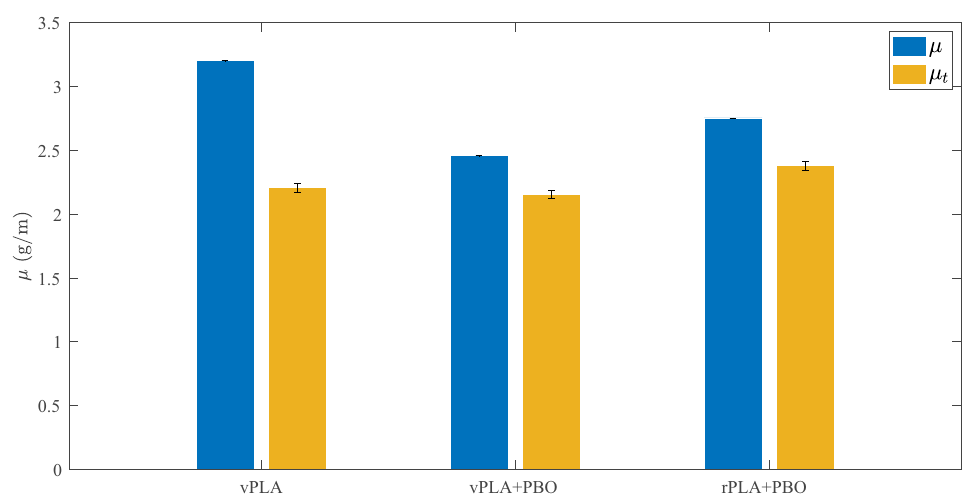
Figure 3. Linear mass density of the filament produced with virgin PLA (vPLA), virgin PLA mixed in the presence of PBO (vPLA+PBO), and recycled PLA mixed in the presence of PBO (rPLA+PBO). Table 2. Characteristics of the filament produced with the virgin PLA (vPLA), recycled PLA (rPLA), virgin PLA mixed in the presence of PBO (vPLA+PBO), and recycled PLA mixed in the presence of PBO (rPLA+PBO). Average Diameter (mm) Filament Length (m) Extrusion Rate (m/s) vPLA rPLA vPLA+PBO rPLA+PBO * Filament average diameter was extrapolated from manual measurements and presented for the sake of